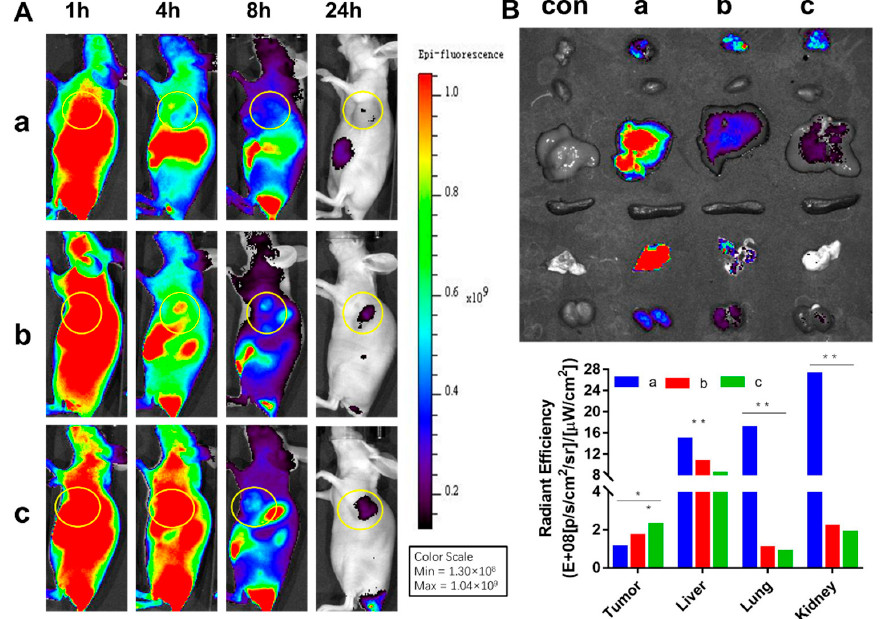
Figure 8. ( A ) The in vivo biodistribution imaging of HepG2 tumor-bearing mice; ( B ) The biodis- tribution imaging of tumor and representative organs; a : ICG; b : CHOL-ICG-LP; c : Dios-ICG-LP. (*: there was significant difference, p < 0.05; **: there was significant difference, p <